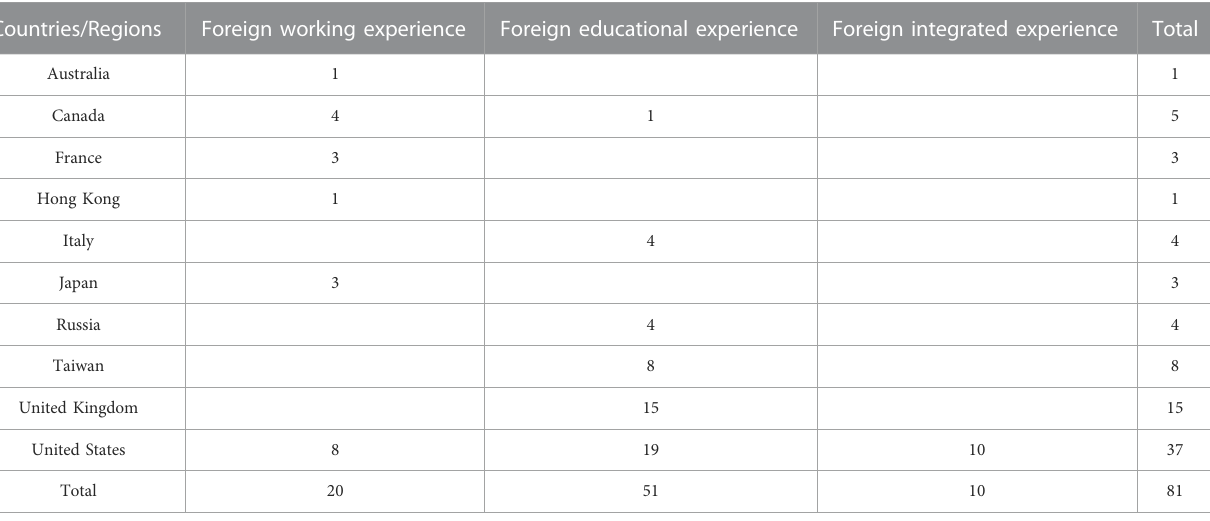
TABLE 3 Distribution of CEO ’ s foreign